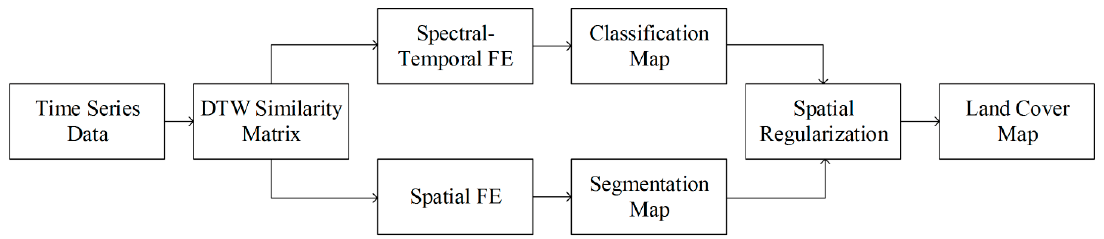
Figure 7. Flow chart of the STS classification method.